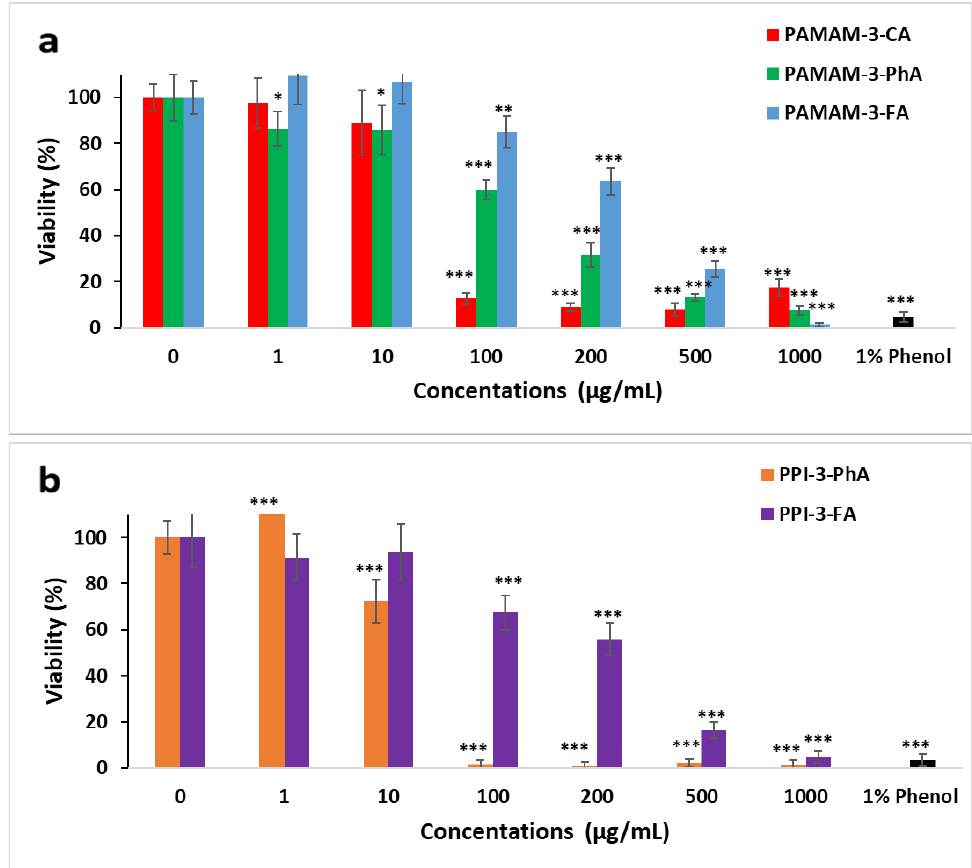
Figure 4. Cytotoxic effects of the phenolic acids ( a ) derived from PAMAM and ( b ) derived from PPI dendrimers on human dermal fibroblast cells, evaluated by a WST-1 assay (*: p < 0.01, **: p < 0.001, ***: p 0.0001).